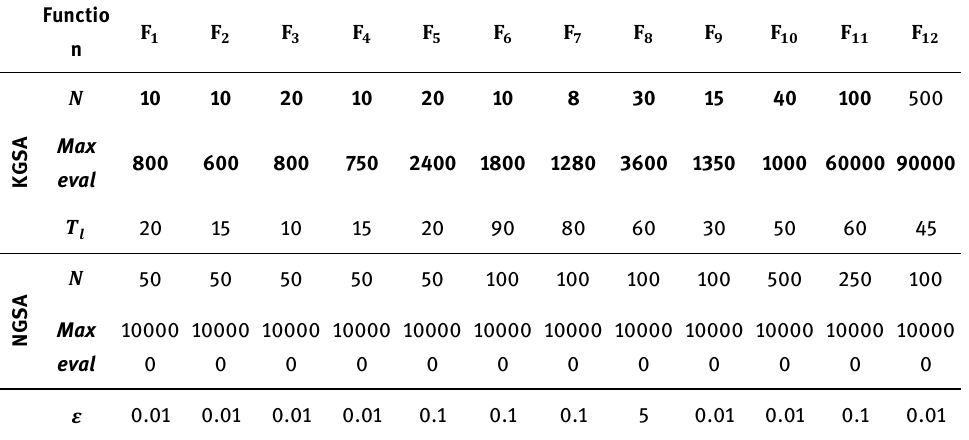
Table 2: List of required parameters for discovering global optima in unconstrained functions